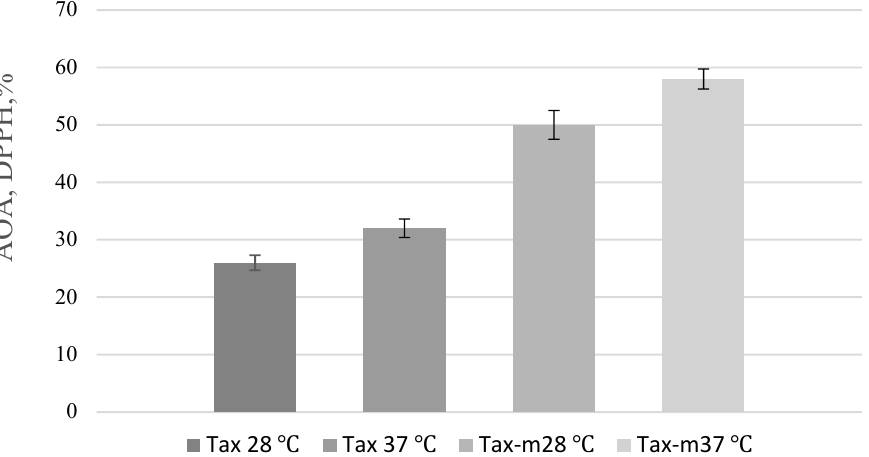
Figure 6. Antioxidant activity of taxifolin encapsulated in yeast, DPPH, %. A clear correlation was established between the AOA and EI values of taxifolin in yeast cells, which was determined to be rather high (r = 0.900, p < 0.05). The preservation of antioxidant properties was 88–91%. Thus, the yeast cells did not significantly affect the DPPH radical scavenging activity of taxifolin. The results obtained are consistent with similar studies on another antioxidant, resveratrol [21], which showed that resveratrol does not lose its antioxidant activity when encapsulated in yeast; a slight increase was observed. In our studies, we did not observe any growth effect. The slight loss of antioxi- dant activity could be due to the incomplete extraction of taxifolin from the yeast cell.